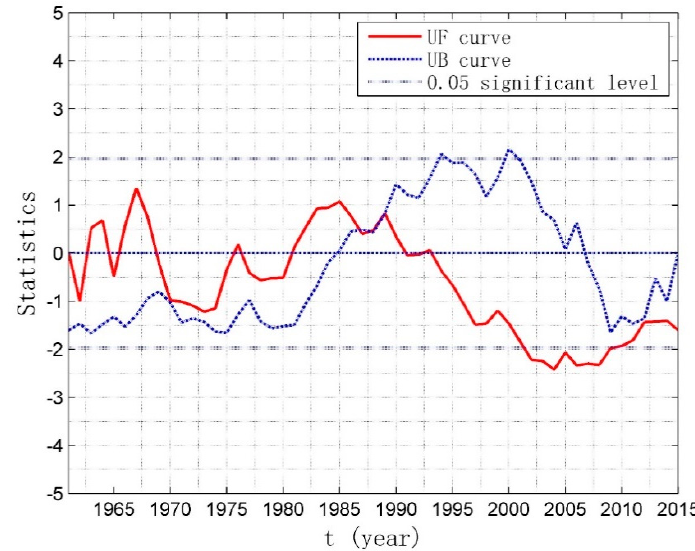
Figure 4. Result of the Mann-Kendall mutation test of the source area of the Yellow River from 1961 to 2015.